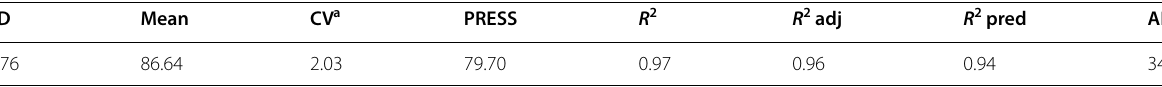
Table 4 Statistical analysis for the response